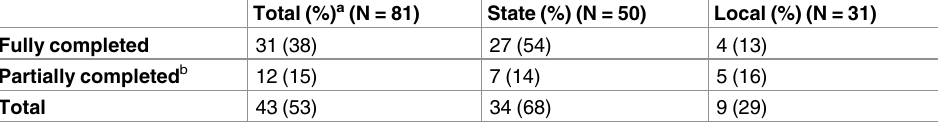
Table 1. Number of state and local health departments responding to an online assessment of mass gathering-related respiratory disease outbreaks, United States, 2009–2014. Assessment administered in March–April